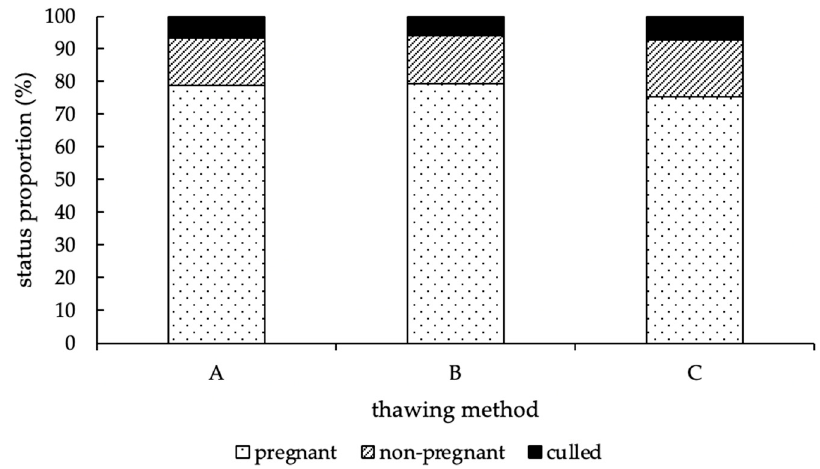
Figure 4. Distribution of the status proportions (in %) at the end of the study, according to the thawing method (A = 11 s, 38 °C water bath; B = 35 s, 38 °C water bath; C = 30 s, “in the cow”). No difference between method A, B, and C could be detected ( p = 0.67).